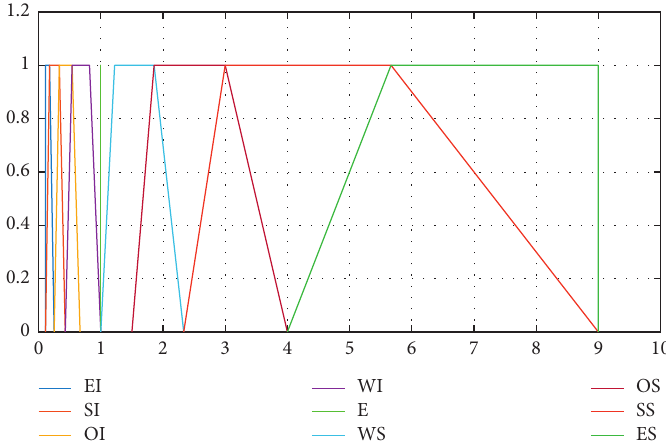
Figure 4: Membership functions of nine-level trapezoid fuzzy number scales (EI-ES). Table 1: The trapezoid fuzzy number values of nine-level scales. Nine-level scale